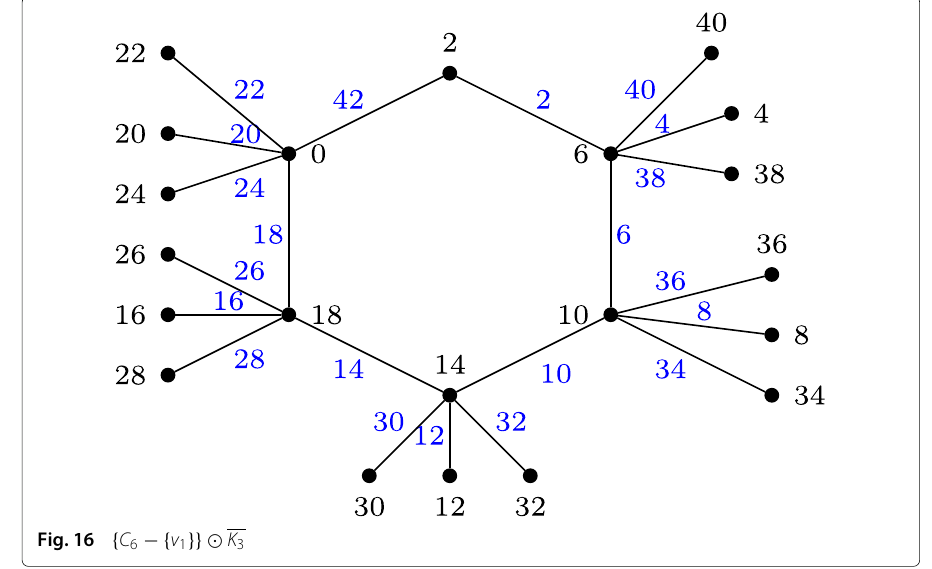
Fig. 16 { C 6 − { v 1 }} (cid:4) K 3